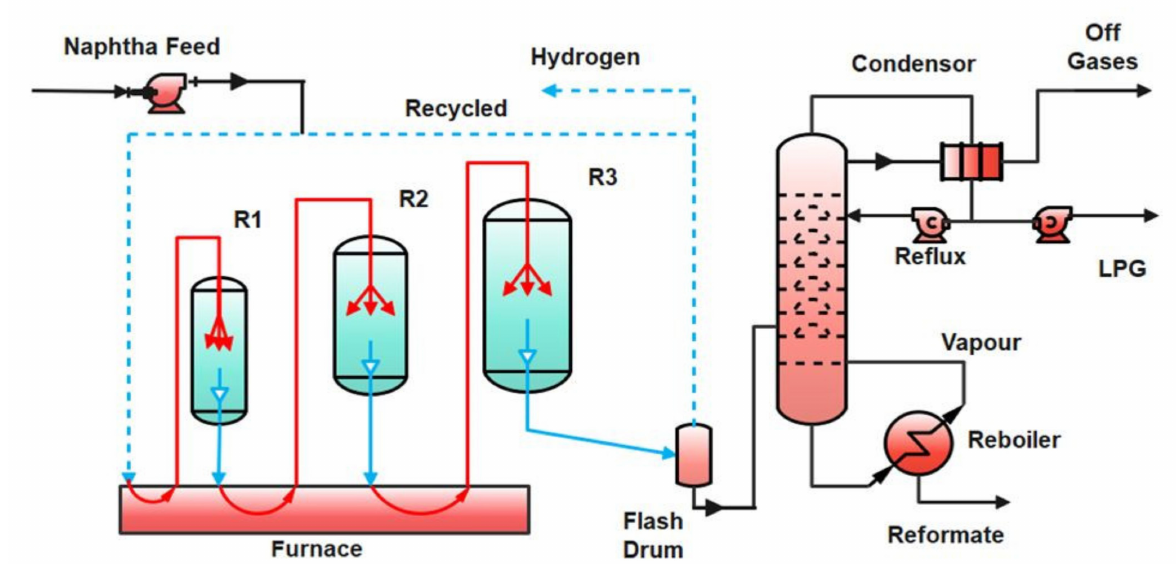
Figure 1. Process flow diagram for the conventional catalytic naphtha reforming process with three reactors (R1, R2, and R3) in series.